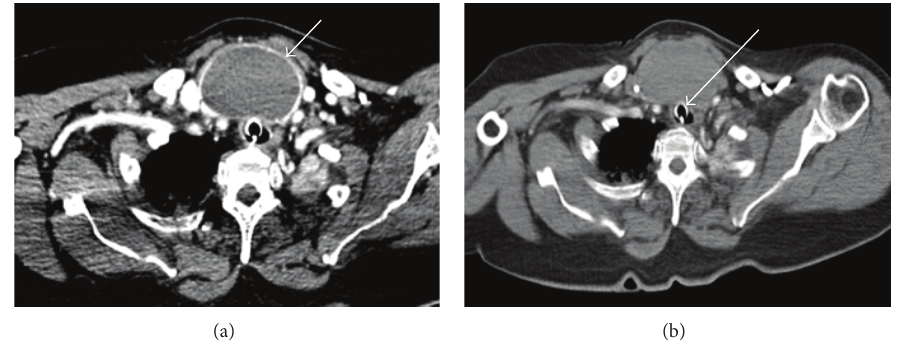
Figure 1: Axial section CT imaging of the neck showing a 7cm anterior cervical mass. A well-defined, nonenhancing, rounded homogenous opacity at the thoracic inlet, within the thyroid isthmus. The endotracheal tube can be visualised within the compressed trachea in (b).